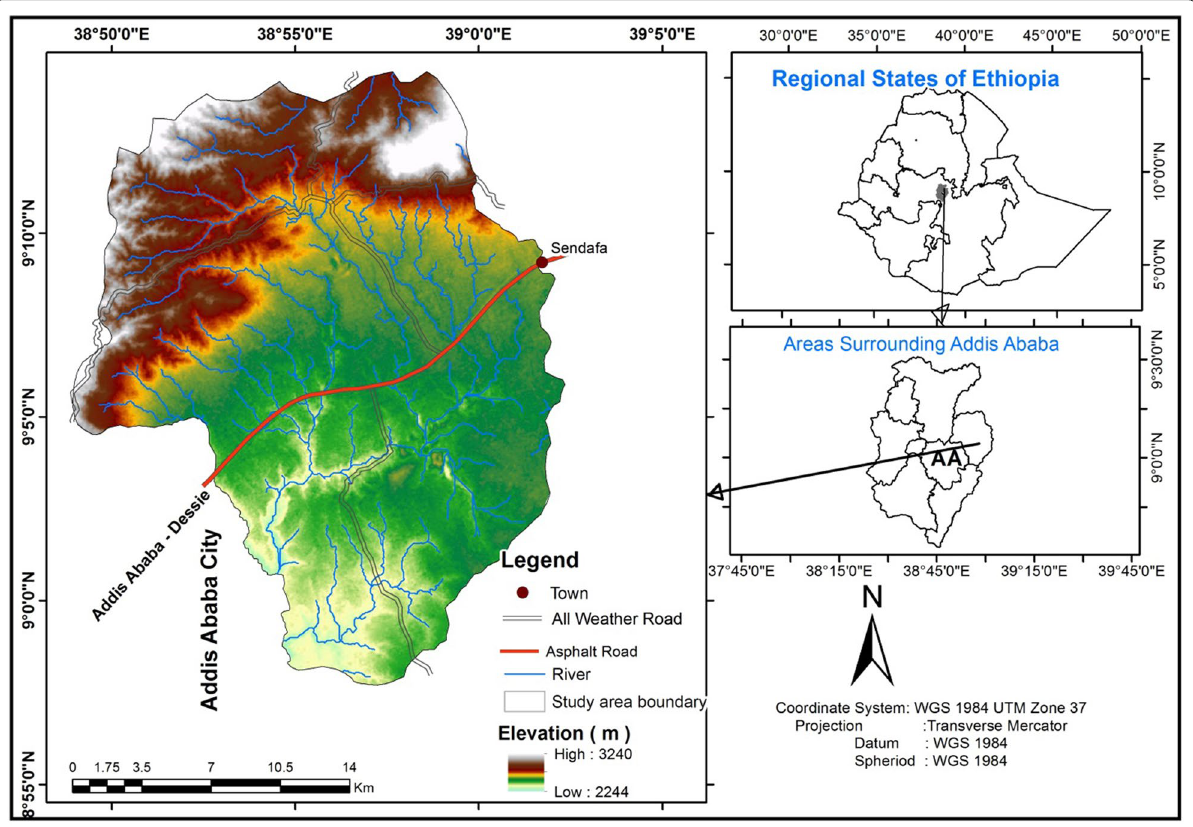
Fig. 1 Location and topography of the study area